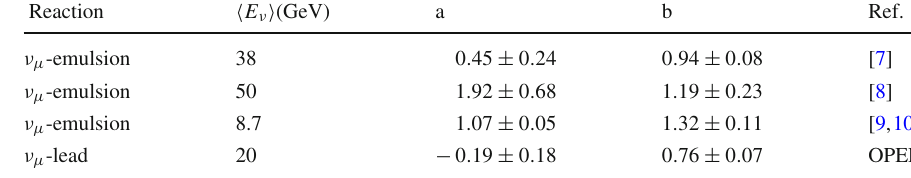
parameters of the linear fit to the average charged hadrons multiplicity dependence on lnW 2 . The results from other experiments are also shown for comparison